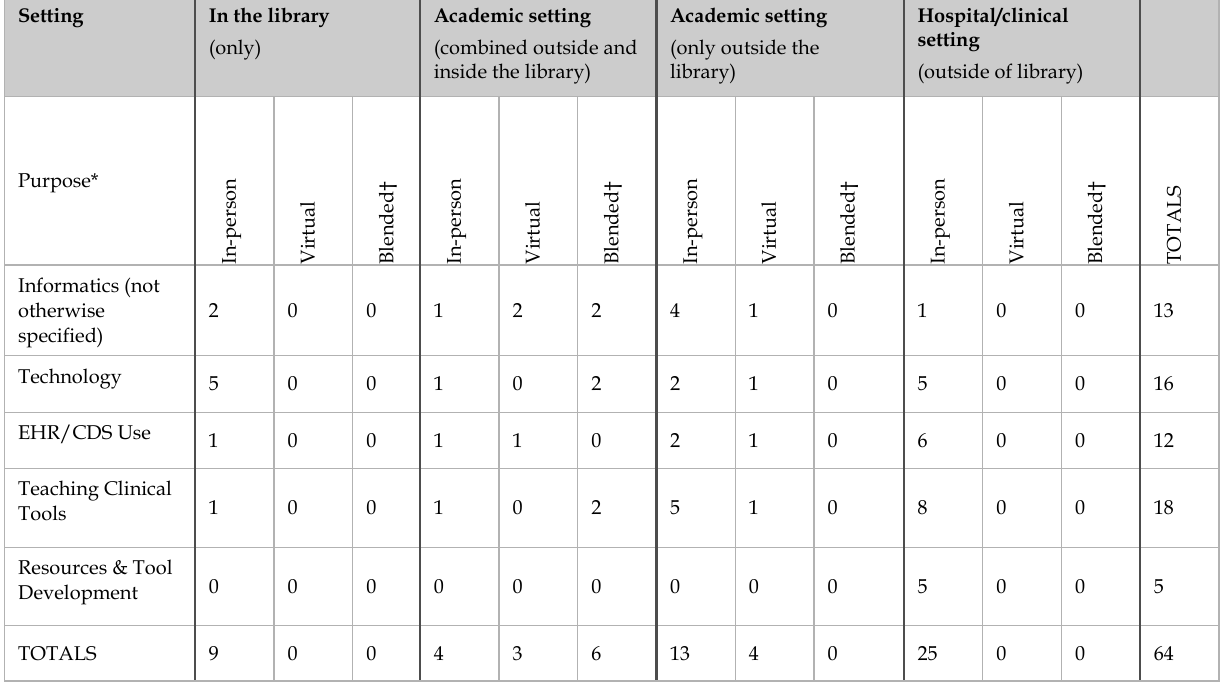
Academic setting (only outside the